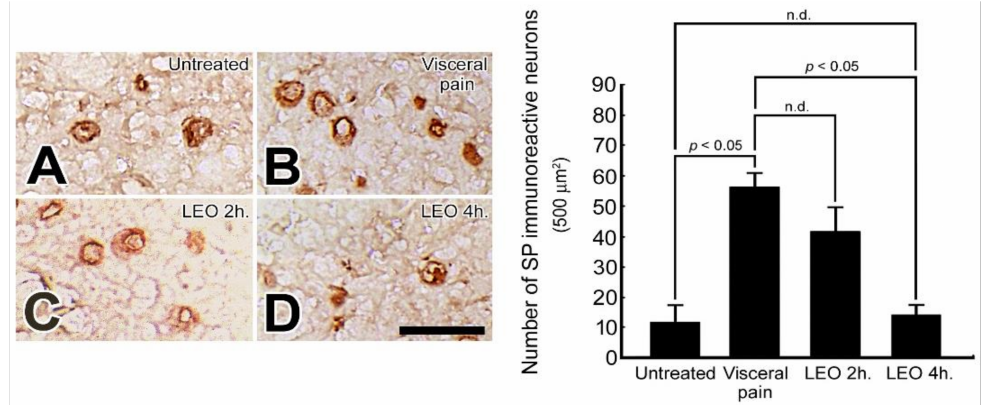
Figure 2. Photomicrographs ( A – D ) and histogram show the SP immuno-expression in the CeA of the untreated ( A ), visceral pain ( B ), and OS groups receiving LEO for 2 h ( C ) and 4 h ( D ). Note that in the untreated group, a few SP immuno-reactive neurons with mild staining intensity were detected in the CeA ( A ). However, following visceral pain, a variety of CeA neurons were positively stained with SP immunoreactivity ( B ). Nevertheless, in rats subjected to visceral pain and who received LEO inhalation, the number of SP immuno-reactive neurons was greatly decreased with the higher change detected in the group received LEO for 4 h. ( D ). Quantitative evaluation coincided well with immunohistochemical findings in which LEO inhalation successfully depressed the SP immuno- expression in the CeA following the induction of visceral pain. n.d. = no significant difference. Scale bar = 12.5 µ